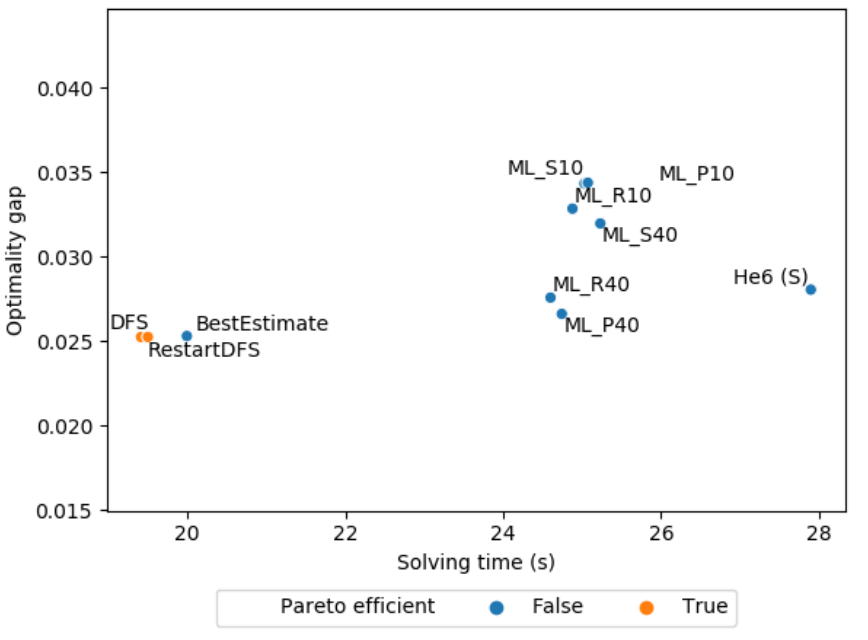
Figure A1. Maximum independent set: average solving time against the average optimality gap of the first solution found at a leaf node. Table A2. Maximum independent set: model ( k = 40) with on_both = PrioChild, on_leaf = RestartDFS and prune_on_both = False against baselines, with equal time limits for each problem. The initial optimality gap obtained by the solver before branch-and-bound is 0.999. Pairwise t -tests against